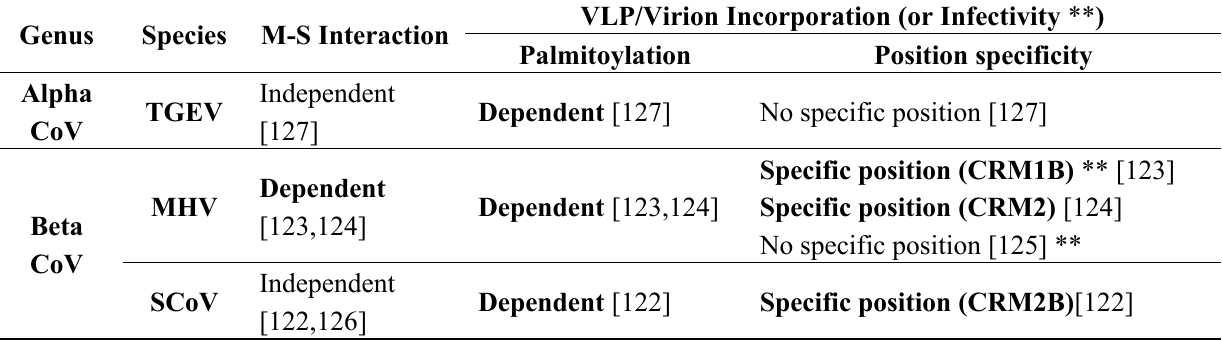
Table 3. Summary of the roles of palmitoylation (cysteine residues) of several CoV-S proteins in M-S interaction and VLP/virion incorporation